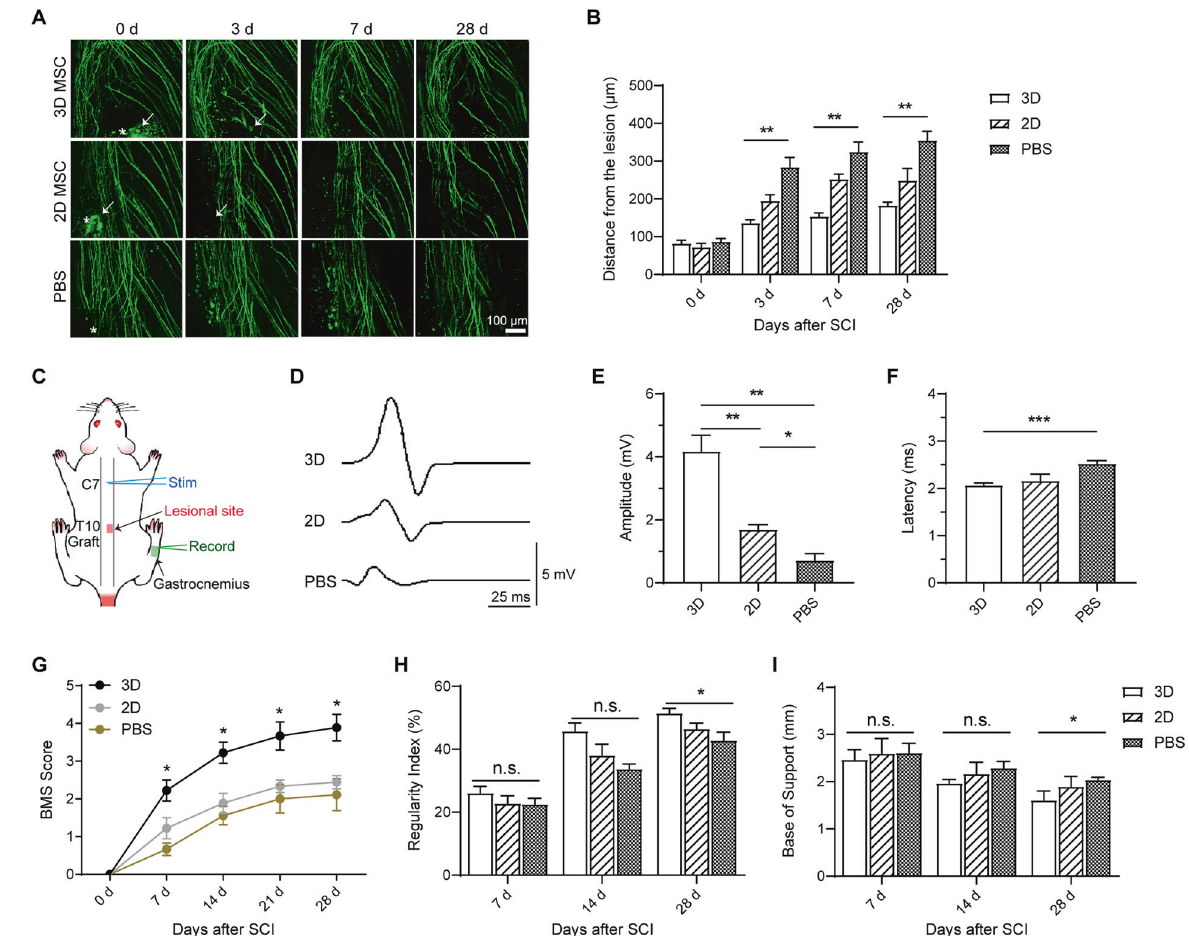
Fig. 5 The therapeutic effects of grafted 3D-HPMSCs on axons and functional recovery. A The in vivo process of axonal dieback at 0 day, 3 days, 7 days, and 28 days post SCI via two-photon microscopy. Some transplanted cells were observed and indicated by the white arrows at 0 days and 3 days. Asterisk indicates the lesion site. Scale bar, 100 µm. B 3D-HPMSCs group showed signi fi cantly shorter axonal dieback after SCI. C The schematic illustration of electrophysiological evaluation. D Representative recording of action potentials in mice with 3D-, 2D- HPMSCs or PBS transplantation. E 3D-HPMSCs group showed higher amplitude compared with 2D-HPMSCs and PBS group at 28 days after SCI. F 3D-HPMSCs group showed shorter latency compared to PBS group at 28 days after SCI. G SCI mice with 3D-HPMSCs transplantation achieved higher BMS score compared to 2D-HPMSCs and PBS groups. H The regularity index in 3D-HPMSCs group was signi fi cantly higher than that in PBS group at 28 d post SCI. I The base of support test suggested a better functional improvement at 28 days post SCI. ∗ , ∗∗ , and ∗∗∗ indicate P < 0.05, P < 0.01, and P < 0.001,